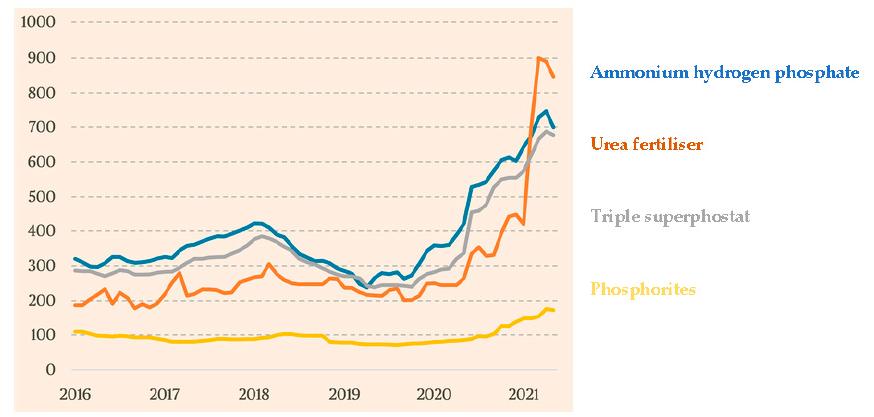
Figure 4. Fertiliser prices on world markets in dollars per tonne [72].